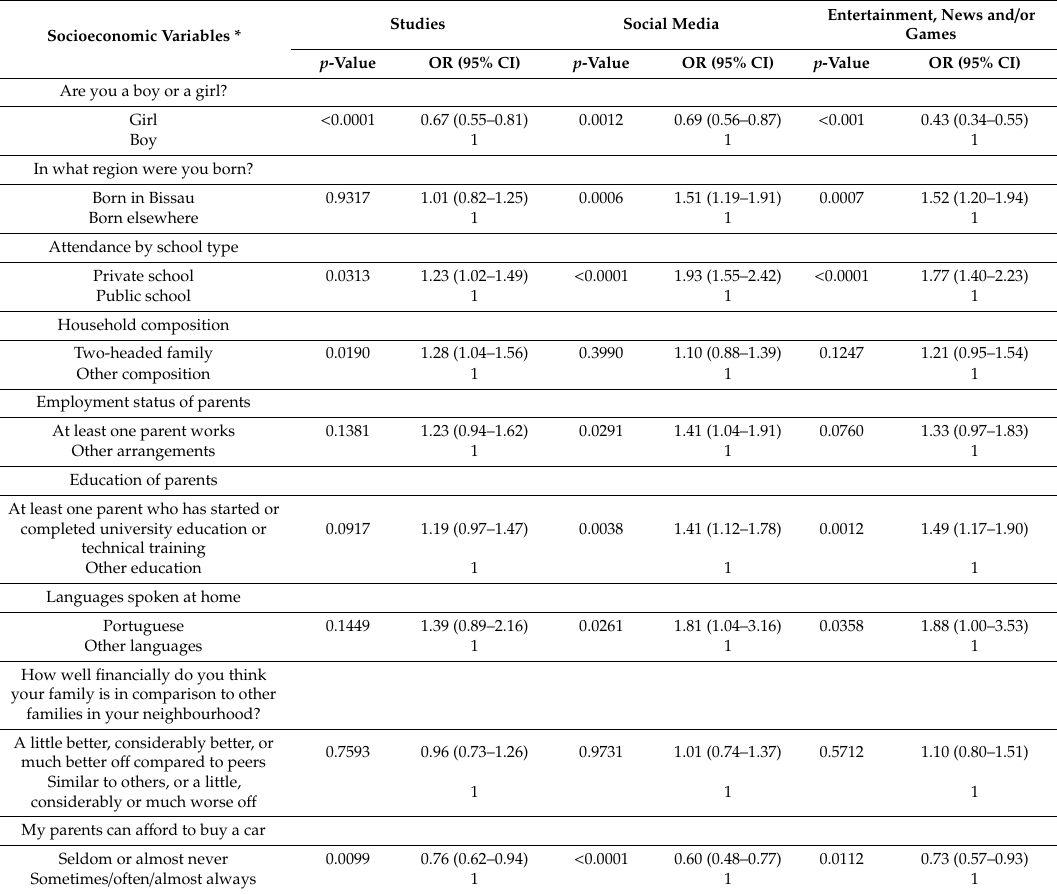
Table 5. Usage of digital technology by selected explanatory socioeconomic variables. Adolescents in schools in Bissau, June 2017